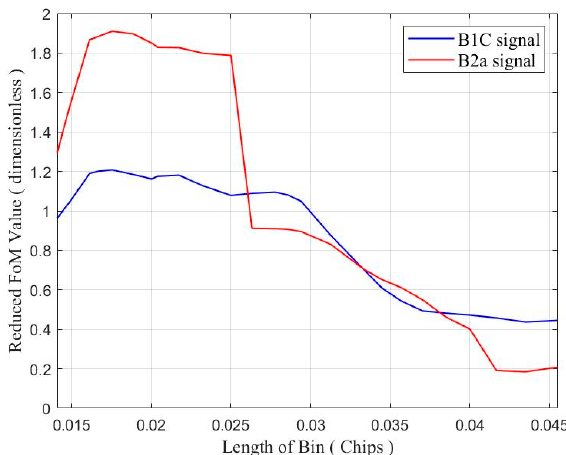
Figure 5. Curves of weighed FoM values after contour reduction, with equal MERRs.